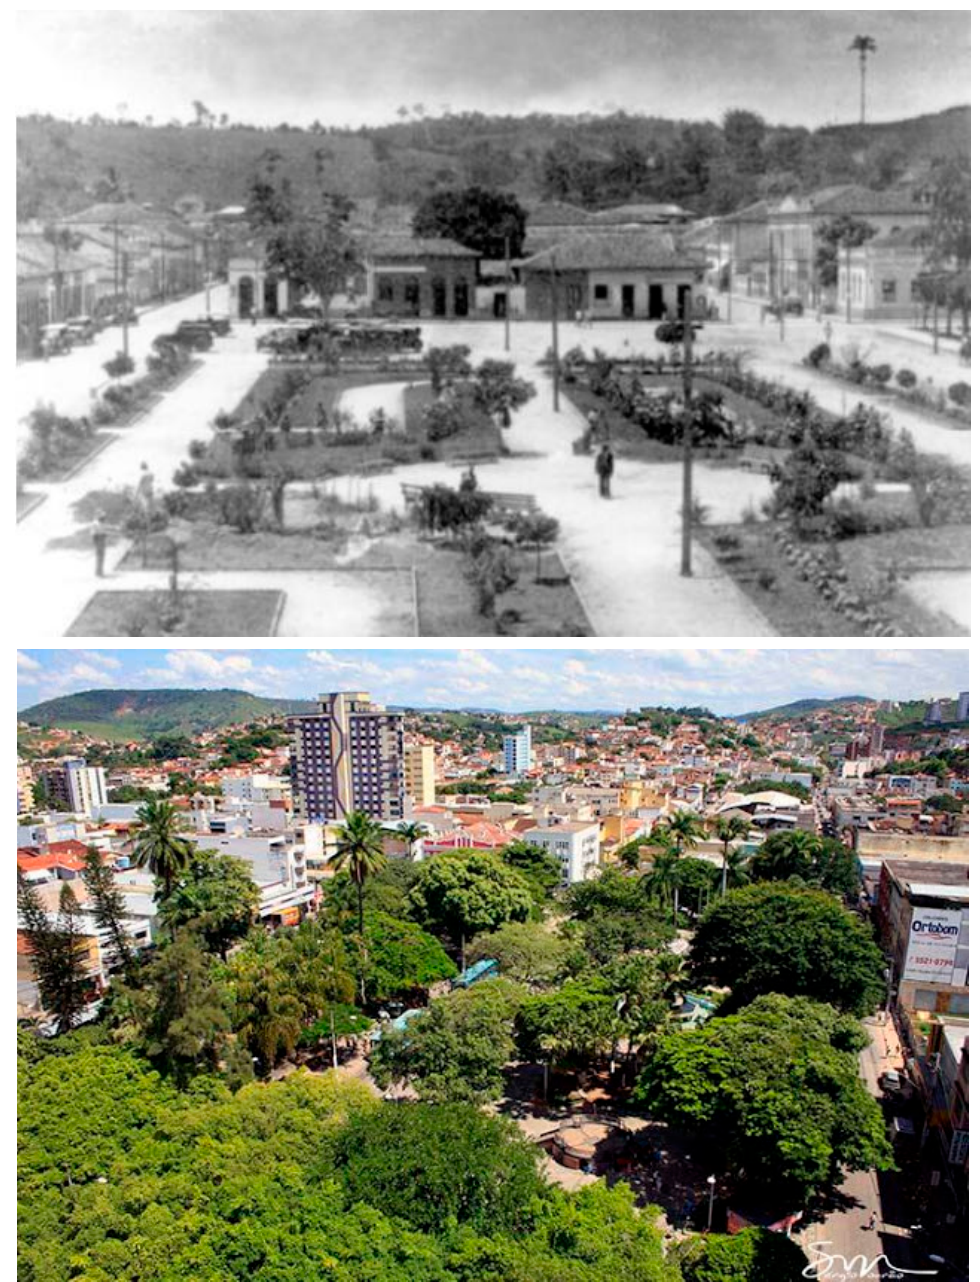
Figure 3. Vintage photograph of the Tiradentes Square, circa 1930, compared to a recent photograph.